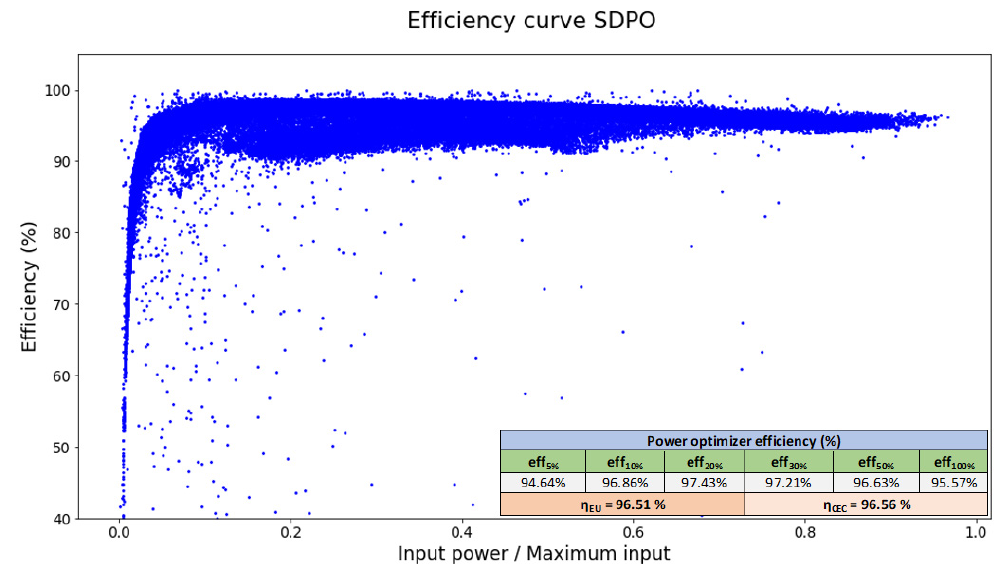
Figure 9. Efficiency curve and calculated η EU and η CEC for the SDPO under test.